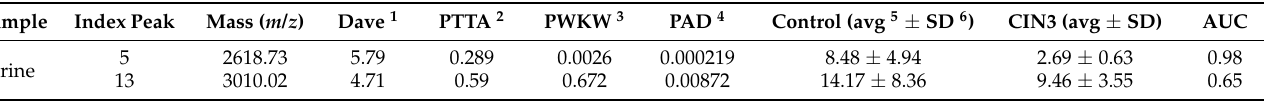
1 Difference between the maximal and minimal average peak area/intensity of all classes. 2 p -value of t test. 3 p value of Wilcoxon test. 4 p -value of Anderson–Darling test. 5 peak area/intensity average of class. 6 Standard deviation of the peak area/intensity average of class.